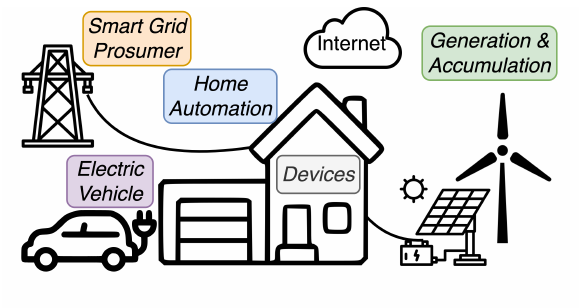
Figure 1. Smart Home energy